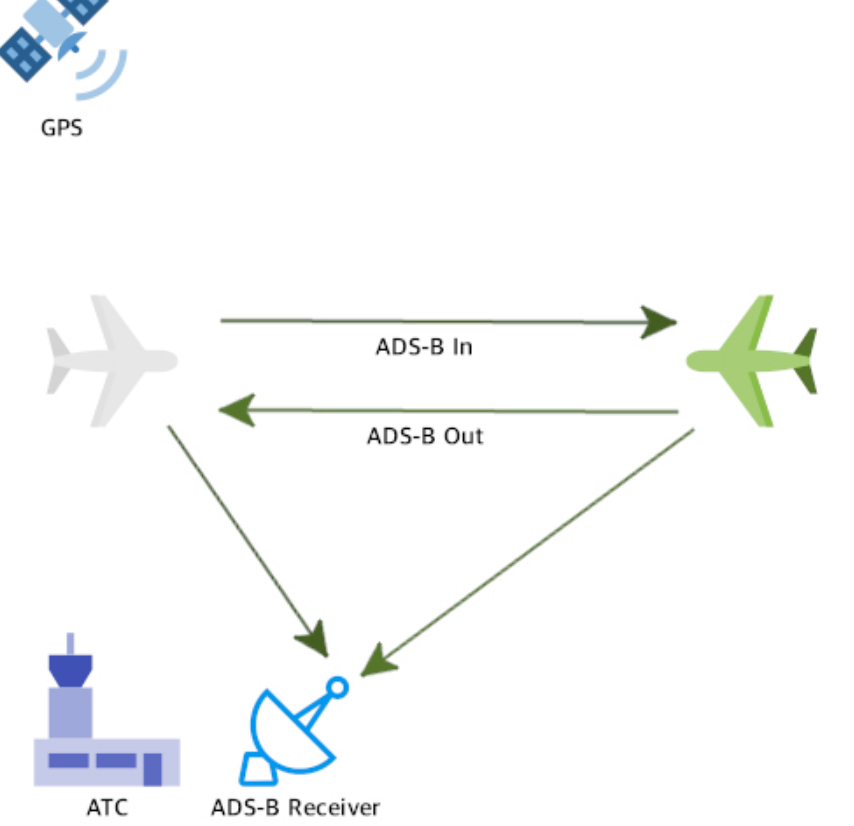
Figure 1. Aircraft use the GPS to determine their location and velocity and then transmit an ADS-B message containing these data using the ADS-B Out subsystem. ATCs use the ADS-B In subsystem to collect ADS-B messages from all aircraft in the area and then display a visual map containing these aircraft. There are aircraft equipped with the ADS-B In subsystem in addition to the ADS-B Out subsystem.